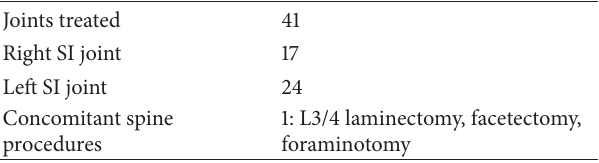
Table 2: Perioperative characteristics.